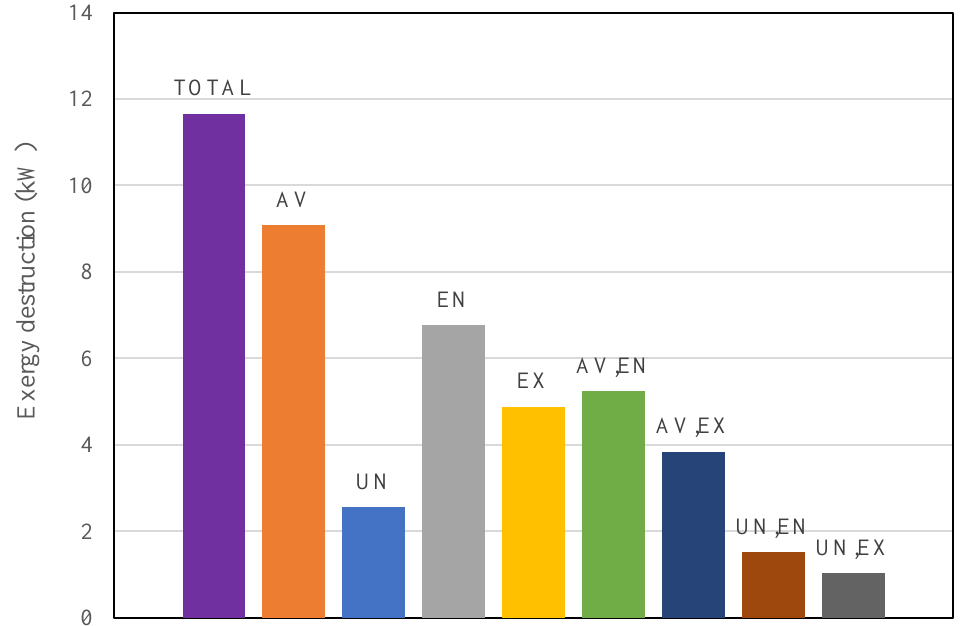
Figure 8. Total exergy destruction rate for the different parts in single-regeneration ORC (SRORC).